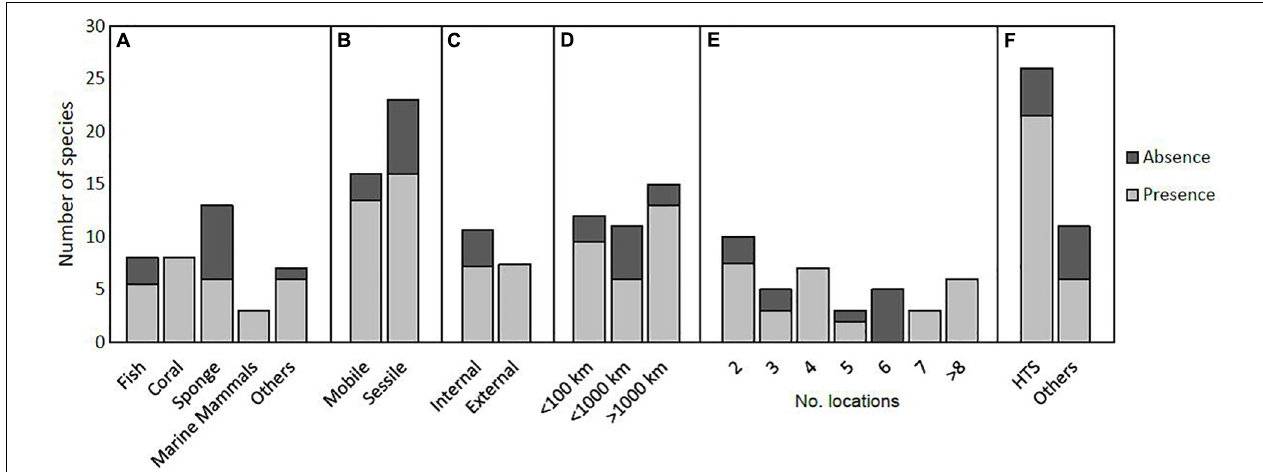
FIGURE 1 | Relationship between detecting presence or absence of species’ microbiome spatial structure and (A) taxonomic group, (B) species traits (mobile vs. sessile species), (C) host tissue sampled (internal vs. external), (D) maximum distance between sampled individuals, (E) number of locations sampled, and (F) analysis method (high-throughput sequencing (HTS) and others). Three species’ microbiomes were tested for more than one tissue type; for example one species where the skin microbiome showed spatial structure but the gut microbiome did not (the fish Elacatinus prochilos ) 0.5 was scored for presence and 0.5 for absence.